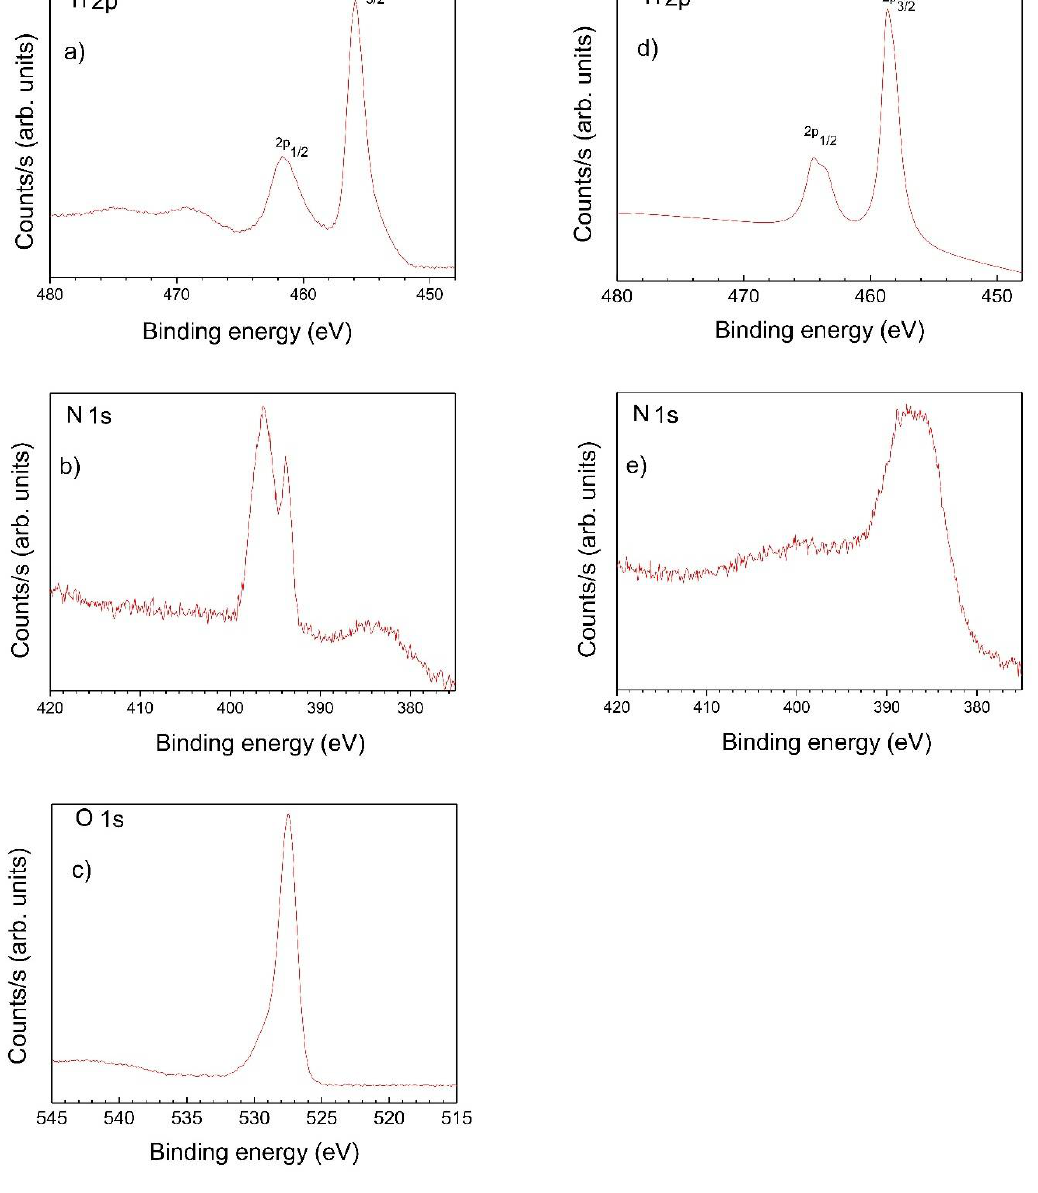
Figure 8. XPS spectra of annealed N-TiO 2 films at 200 ◦ C: ( a ) Ti 2p, ( b ) N 1s, ( c ) O 1s at 350 ◦ C, ( d ) Ti 2p, and ( e ) N 1s.